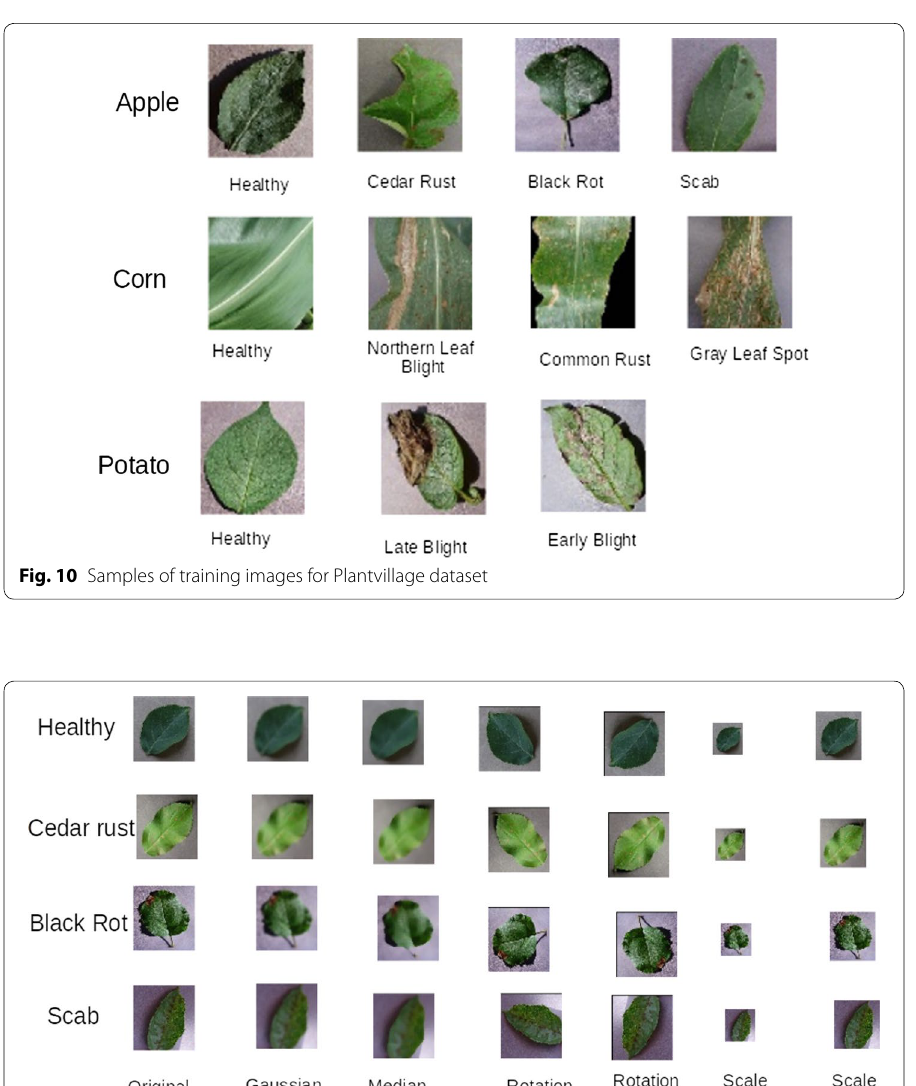
Fig. 10 while the sample of the test data (apple) with the resulting transformed images are depicted in Fig. 11.